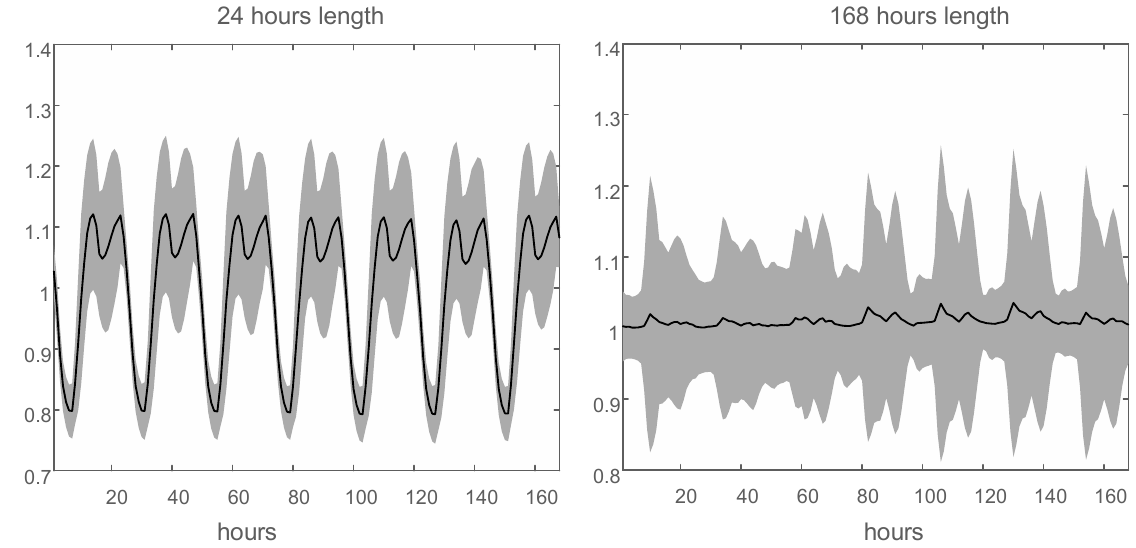
Figure 7. Distribution of the initial seasonal indices for the AMC 24,168 model using the Winters method. In the left part, the seasonality of 24 hours is used, and in the right part the seasonality of 168 hours is used. The central line represents the average of the values, regardless of the time of the year, while the shaded area represents the variability with ± standard deviation.